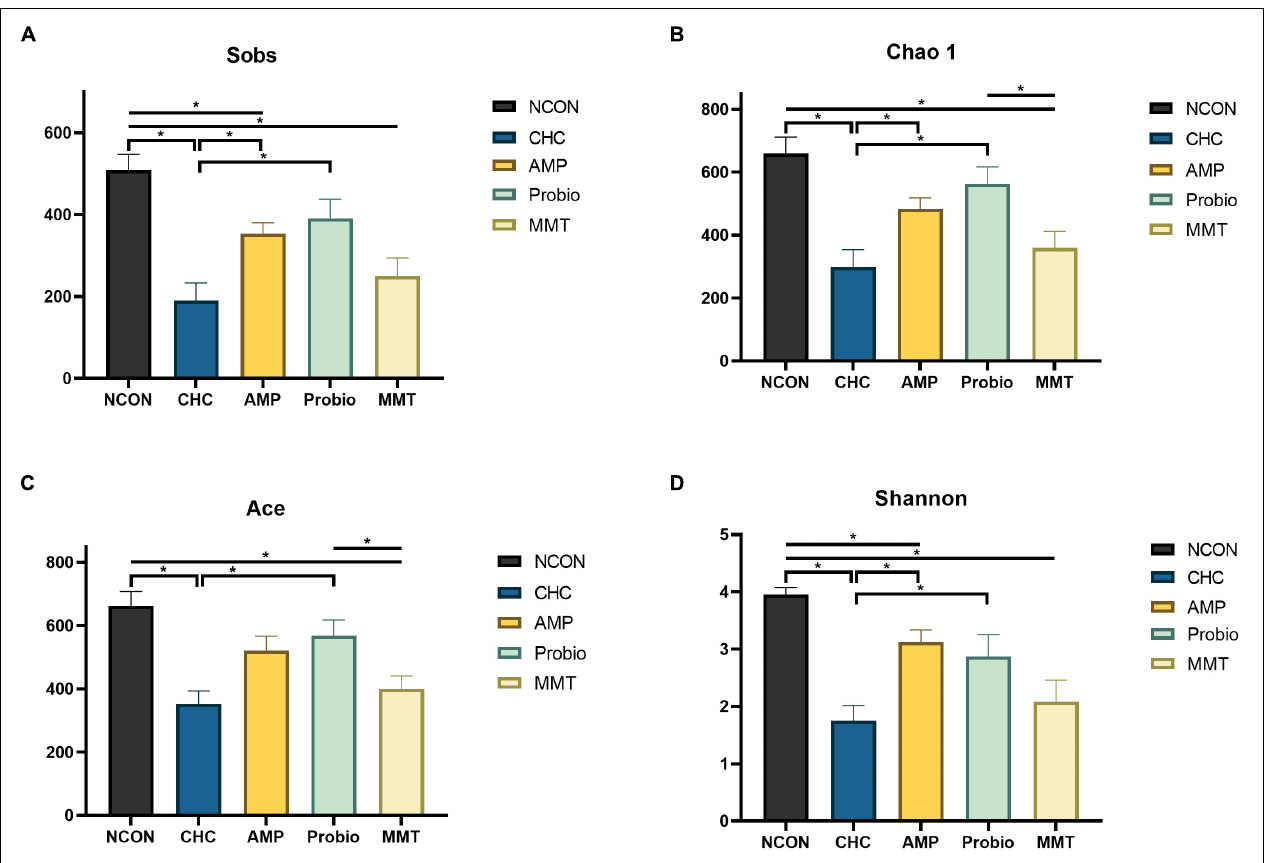
FIGURE 2 | Effects of CHC on α -diversity of ileal microbiota in broilers on day 42. (A) Represents Sobs index. (B) Represents Chao 1 estimator. (C) Represents ACE estimator. (D) Represents Shannon index. Four indexes analyzed the α diversity of broilers from different directions. NCON is the corn-soybean meal basal diet group. AMP is a 200 mg/kg antibacterial peptide supplemented group. Probio is 200 mg/kg calsporin supplemented group. MMT is 500 mg/kg montmorillonite supplemented group. CHC is 500 mg/kg activated charcoal-herb extractum complex supplemented group. The Kruskal-Wallis test was used for comparing multiple groups, and Mann–Whitney U test was used for two groups. The “*” indicates p < 0.05.